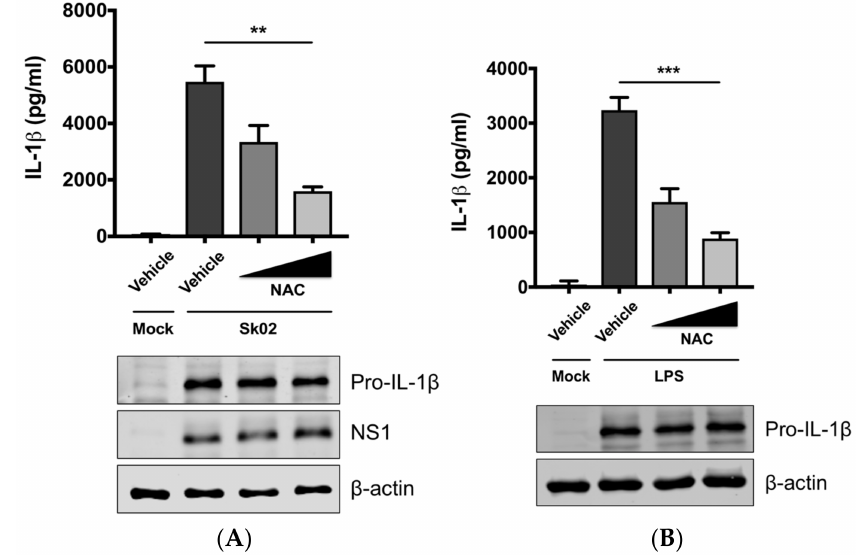
Figure 2. Reactive oxygen species (ROS) plays a critical role on SIV-induced IL-1 β production in PAMs. PAMs were either infected with Sk02 at an MOI of 1 for 20 h ( A ) or stimulated with 200 ng/mL LPS for 16 h ( B ) in the presence of vehicle (distilled water) or increasing concentrations (2 and 10 mM) of a ROS scavenger, NAC. Porcine IL-1 β levels from the supernatants were measured by ELISA and the expression of pro-IL-1 β , viral NS1, and β -actin was analyzed by Western blotting. Statistical analysis was done with a one-way ANOVA. ** p < 0.01; *** p < 0.001. Results are representative of three independent